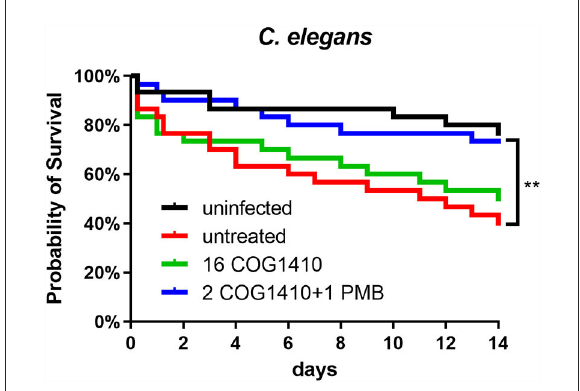
FIGURE8 The combined therapy of COG1410 and polymyxin B rescued infected nematodes. The cultures of C. elegans were pre-infected with A. baumannii YQ4 and transferred to an NGM plate supplemented with 16 µ g/ml COG1410 or 2 µ g/ml COG1410 and 1 µ g/ml polymyxin B. The dead nematodes were counted every day for 2 weeks. The survival curve was analyzed by Kaplan–Meier method, and the statistical significance was analyzed by the log-rank test. ** p < 0.01.